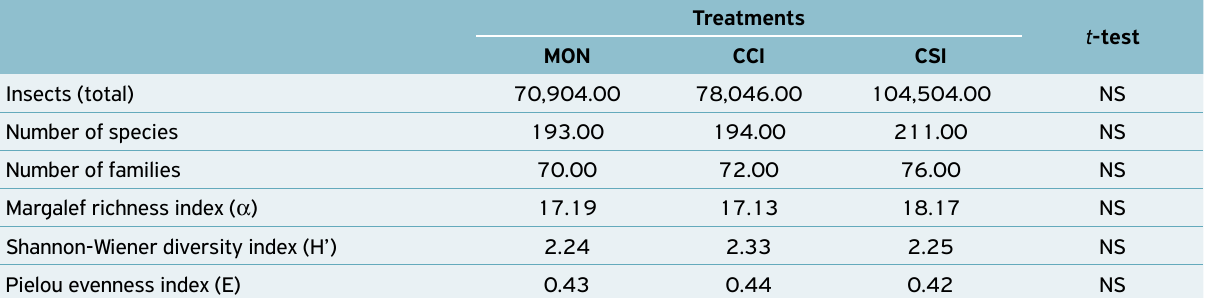
Table 1. Total insects collected, number of species and families, richness, diversity and evenness indices and significance of the t -test (p = 0.05) for the treatments genetically modified maize and conventional maize with and without insecticide sprays in Ponta Grossa, PR, Brazil.